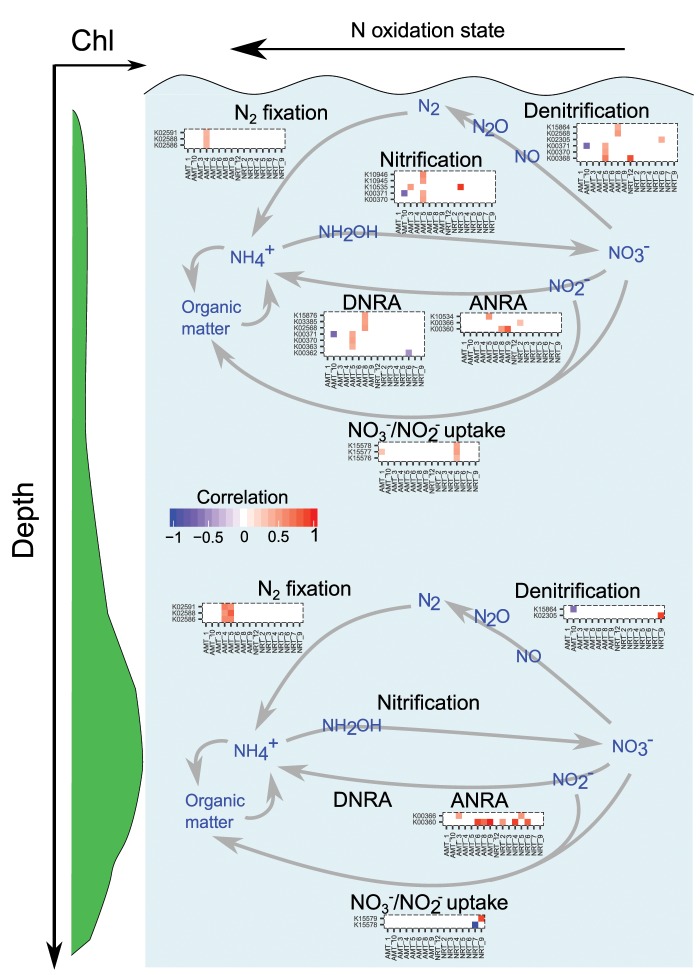
Correlation of diatom DiAMT1/DiNRT2 mRNA abundances against prokaryotic N metabolism gene abundances. The color code indicates the Pearson coefficient for those statistically significant correlations (P value < 0.05). While diatom N transporter abundances are retrieved from the 20–180 µm size fraction, prokaryotic data are obtained from the 0.22–1.6/3 µm ones. Most of the significant correlations have been detected on the DiAMT1 clades and at surface, suggesting a closer relationship between NH4+ transporters and prokaryotic modules at this specific depth. Abbreviations: DNRA, dissimilatory nitrate reduction to NH4+; ANRA, assimilatory nitrate reduction to NH4+. The enzyme names and definitions for the KEGG orthologous groups (KO) are displayed in supplementary table S3, Supplementary Material online.